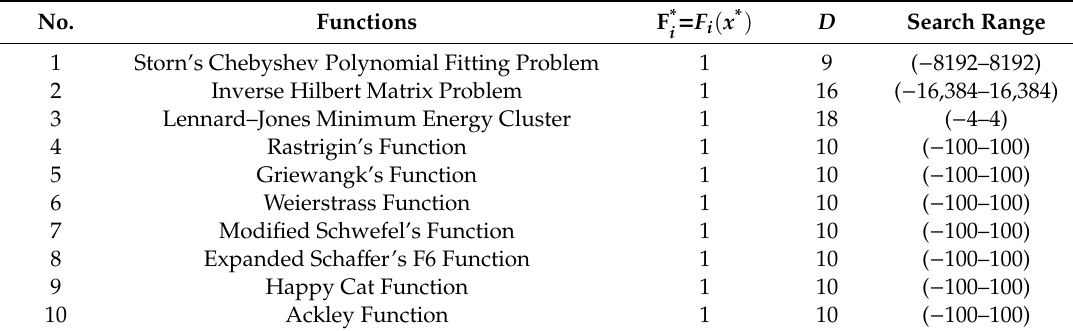
Table 1. The basic parameters of the 100-Digit